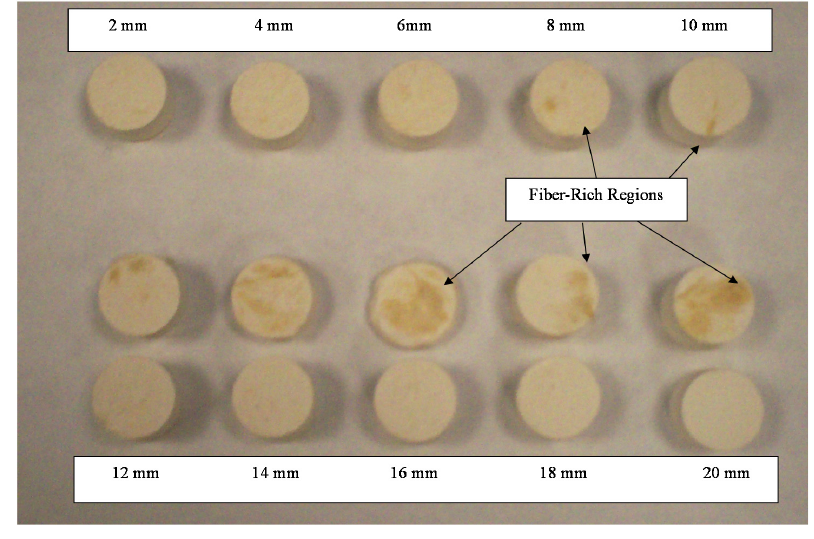
Figure 2. Stress-strain curve for a hemp sample, circled portion shows delamination plateau.